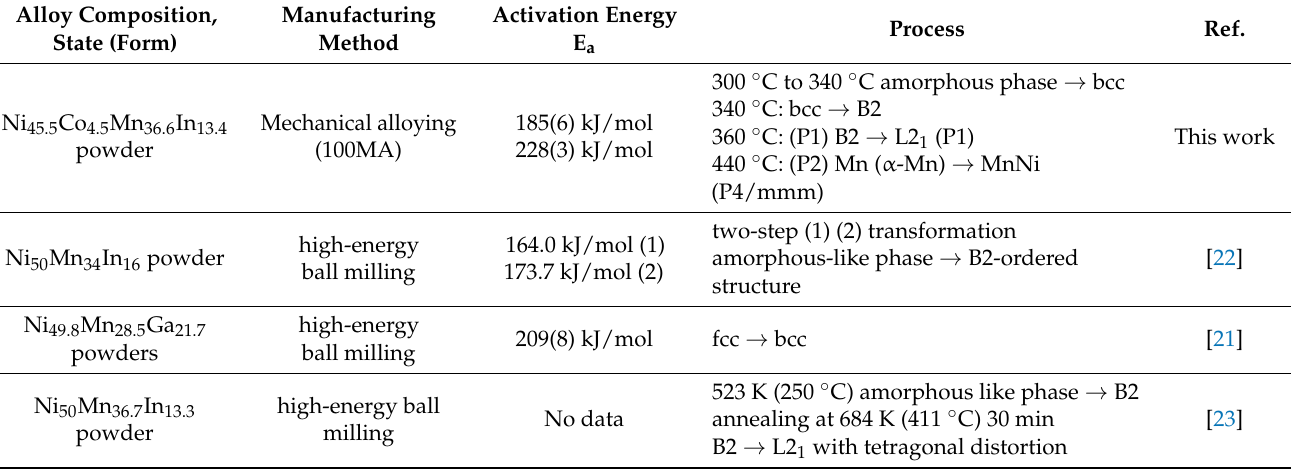
Table 3. The activation energies (E a ) and transformation sequences observed in MnMn-based alloys obtained by different